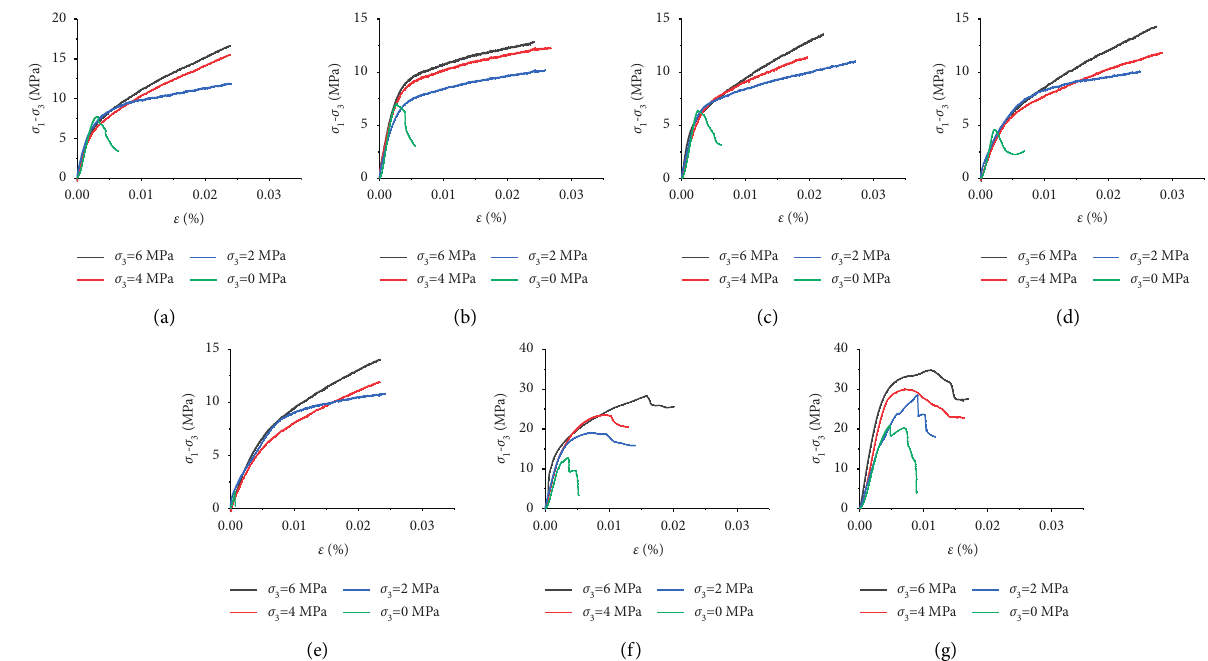
Figure 8: Stress-strain curves of Group AC layered composite rock under triaxial compression: (a) β � 0 ° , (b) β � 15 ° , (c) β � 30 ° , (d) β � 45 ° , (e) β � 60 ° , (f) β � 75 ° , and (g) β � 90 °